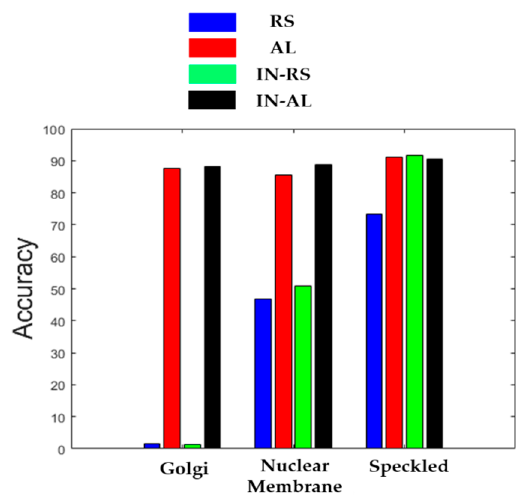
Figure 14. Classification results of the “IN-AL” case: ( a ) features’ visualization and ( b ) confusion matrix.